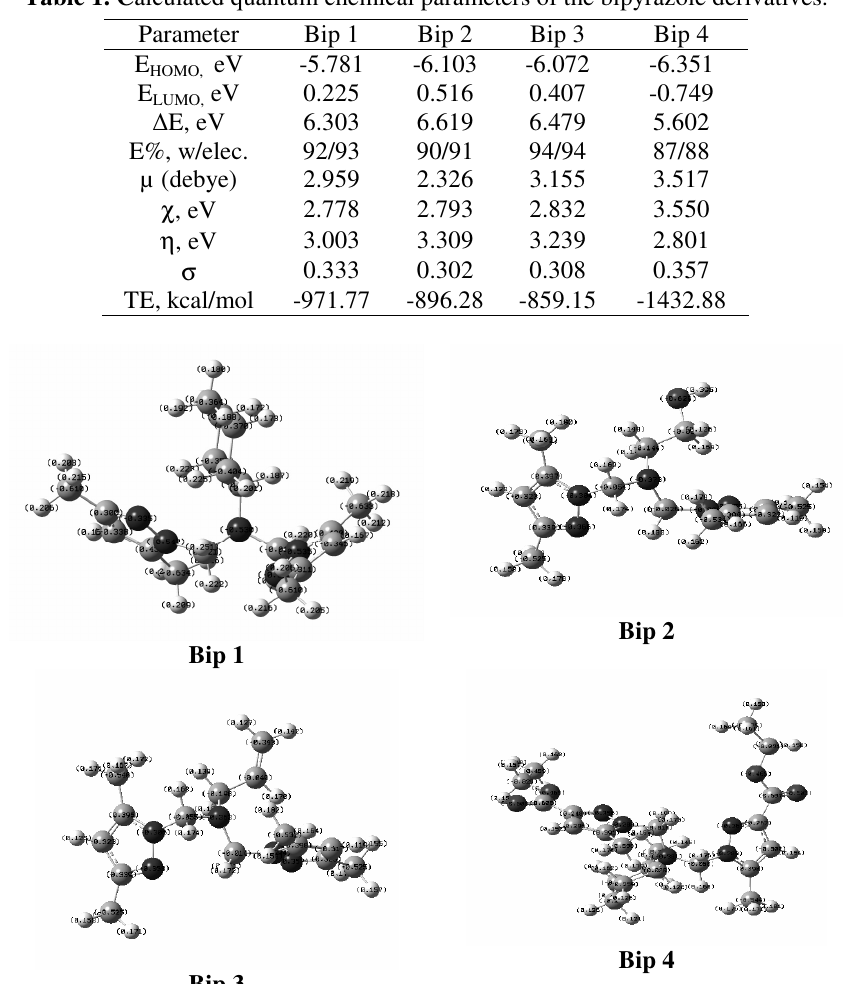
Table 1. C alculated quantum chemical parameters of the bipyrazole derivatives.